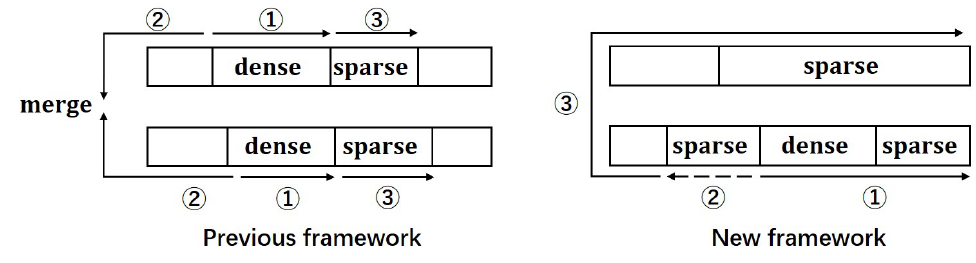
Figure 4: Comparison between our framework and previous frameworks [LMW17, MPS +